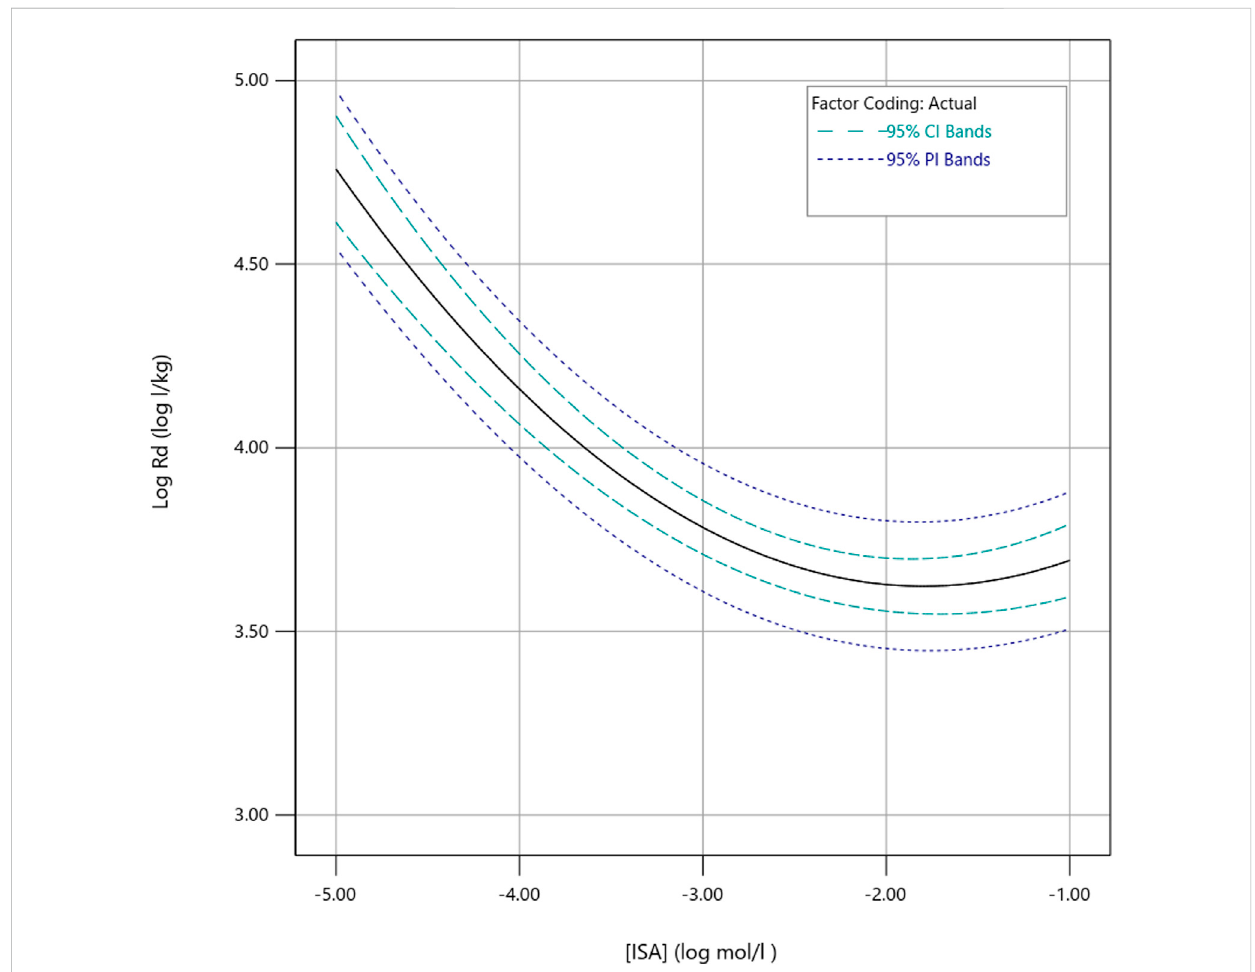
FIGURE 3 Model predictions for R d as a function of the ISA concentration, for a fi xed [Ca 2+ ] of 3.09 mM. Both the best estimate and a 95% prediction interval and con fi dence interval are